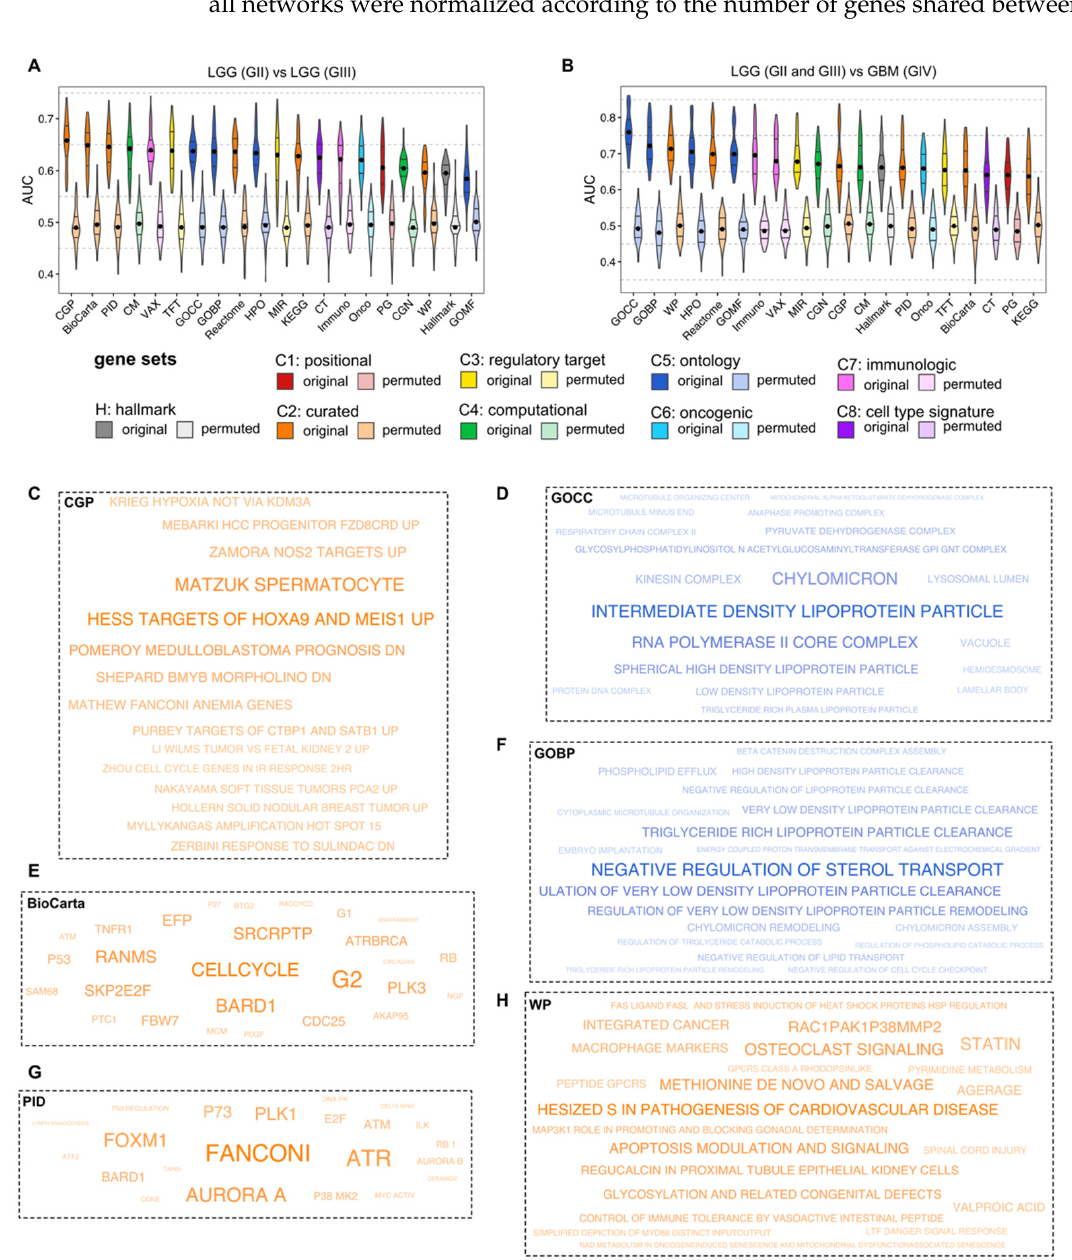
Figure 3. ( A , B ) Evaluation of MSigDB collections using ML models with feature selection for discerning glioma grades using ssGSEA scores. Five different ML approaches were used: SMO, IBk, Bagging, J48 and JRip. Each ML method was undersampled 20-times with 10-fold CV. The median was marked with a black dot on each violin. Panels ( C , E , G ) represent MCFS results for the top three collections for GII vs. GIII. Size of annotations represents RI values from MCFS. Panels ( D , F , H ) represent MCFS results for the top three collections for GII vs. GIII. Size of annotations represents RI values from MCFS.